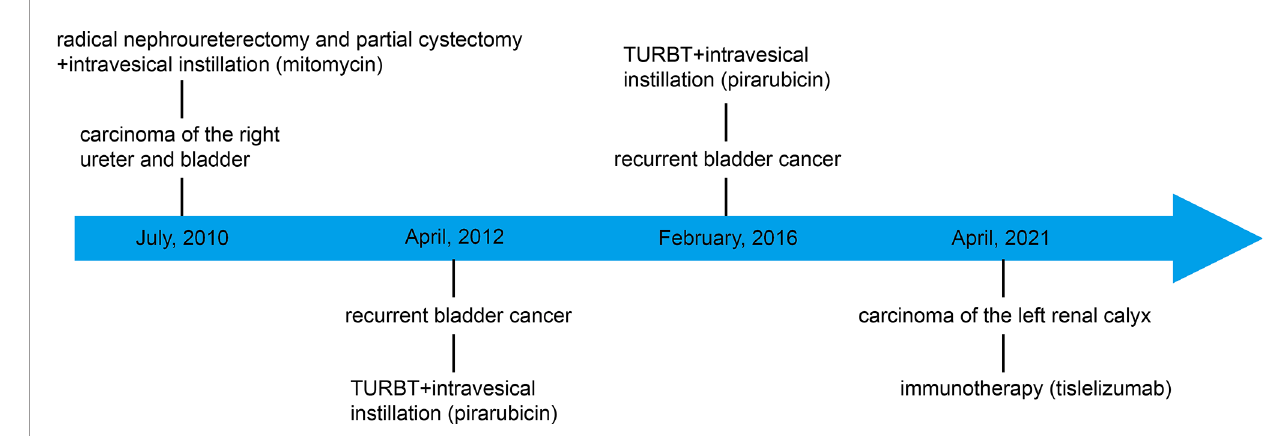
FIGURE 1 | Timeline of the case